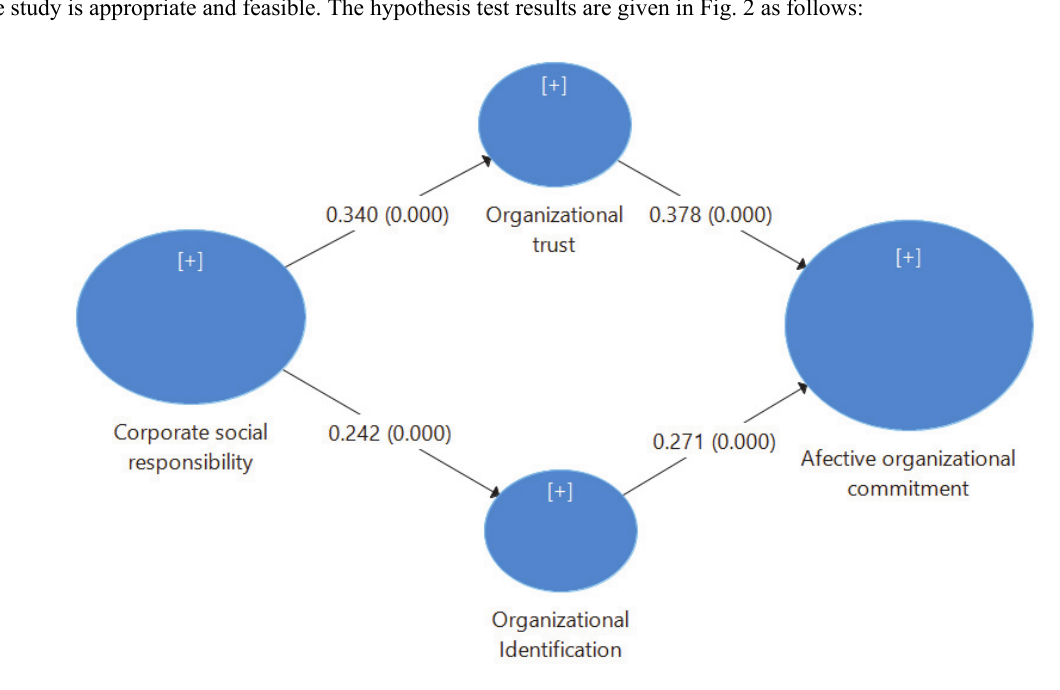
Fig. 2. Hypothesis test